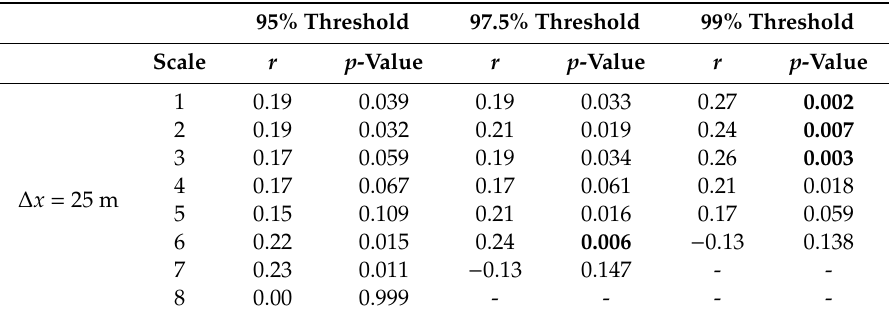
Table 1. Spearman rank correlation r and its p -value between height and the wavelet variance of the inter-extreme time series of the wind extremes for di ff erent thresholds. The results below the significance level of 0.01 are in bold.